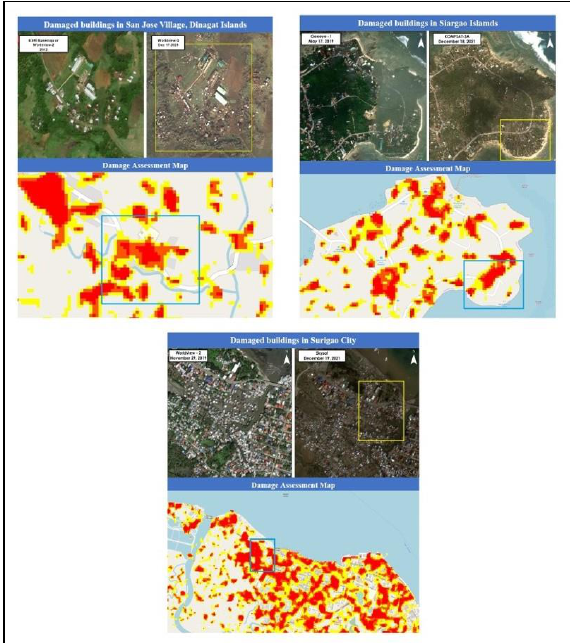
Figure 18 . Comparison of CCD result with high resolution images from reliable